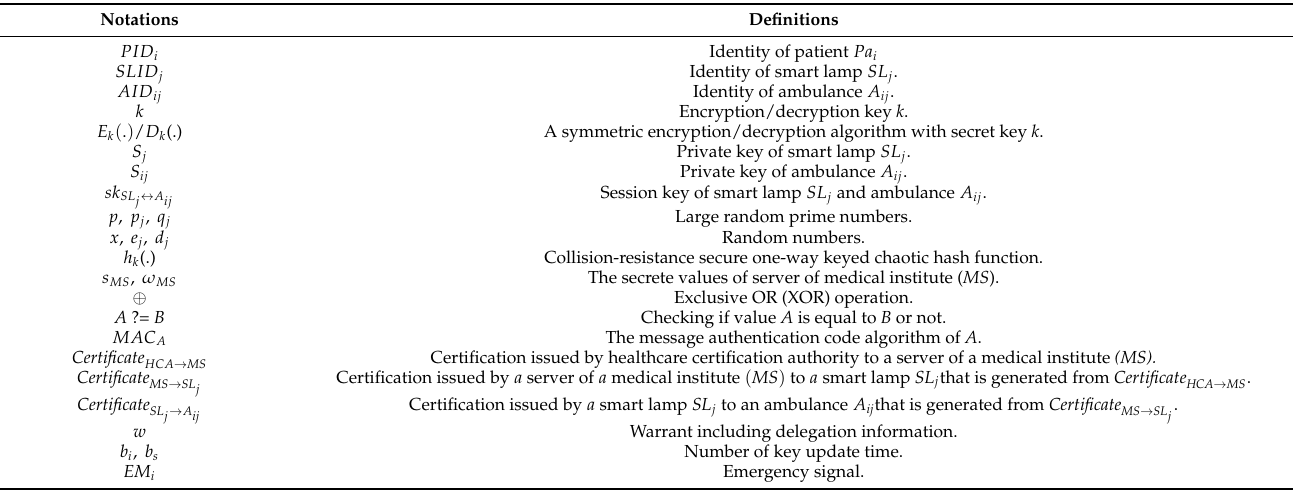
Table 2. Notations of proposed scheme.